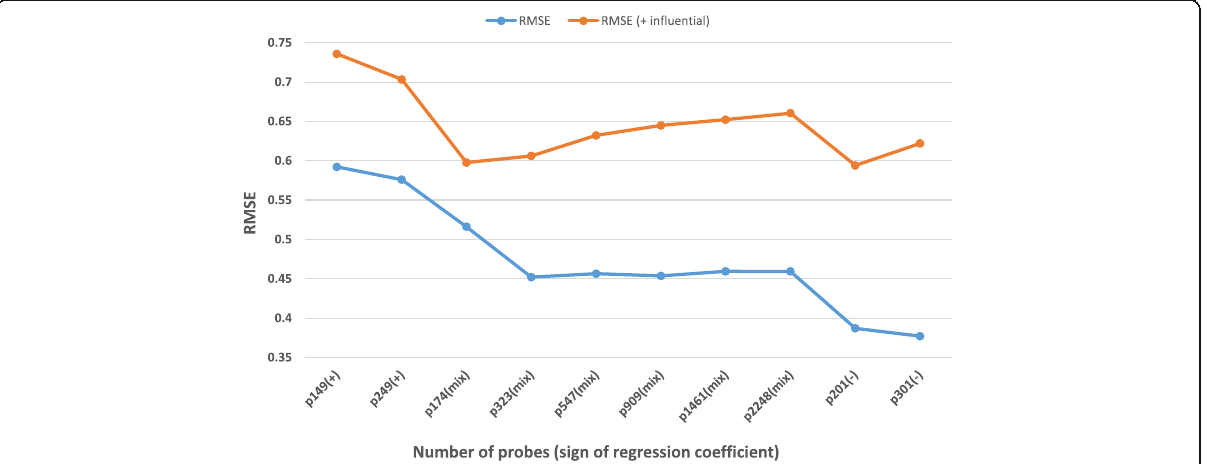
Fig. 2 RMSE values in the validation set (with or without influential observation) of PLS-3 signatures with different number of probes ((+) only probes with positive regression coefficients, (mix) probes with both positive and negative regression coefficients, and( − ) only probes with negative regression